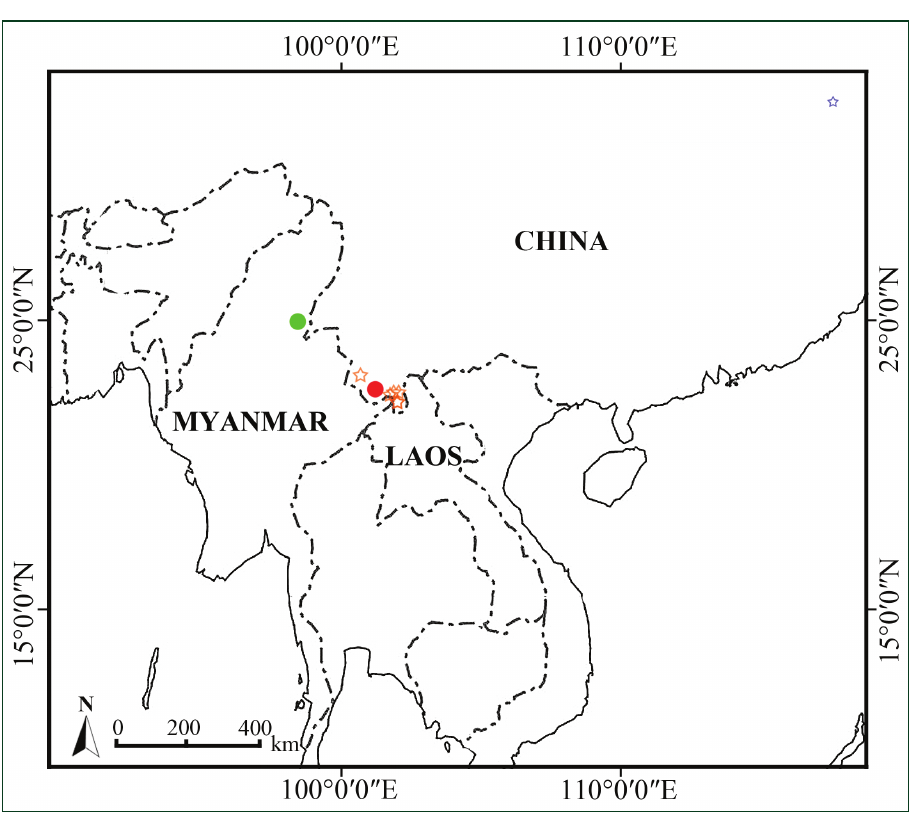
Figure 4. Distribution map of Premna bhamoensis (green circle showing the type locality and red circle for the cultivated cite) and P. menglaensis (orange